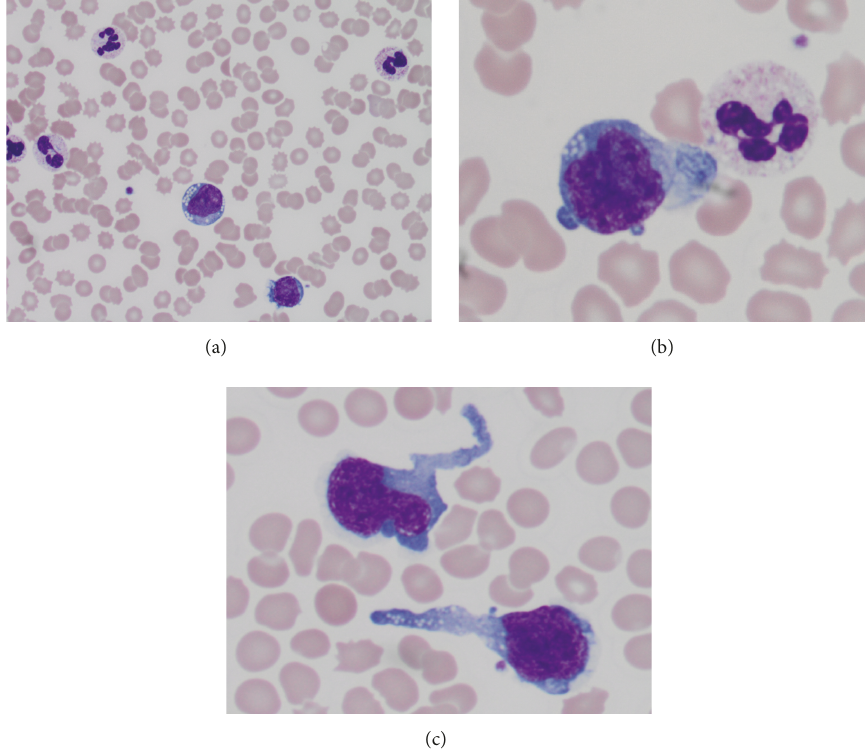
Figure 1: Peripheral blood examination. (a) The patient’s peripheral blood smear shows leukocytosis with neutrophilia, left shift, and toxic granulation (Wright’s stain, 40x). (b) Scattered medium size atypical cells are present. These cells feature prominent nuclear irregularities and vacuoles (Wright’s stain, 100x oil). (c) Atypical cells have pseudopodial cytoplasmic projections (Wright’s stain, 50x oil).